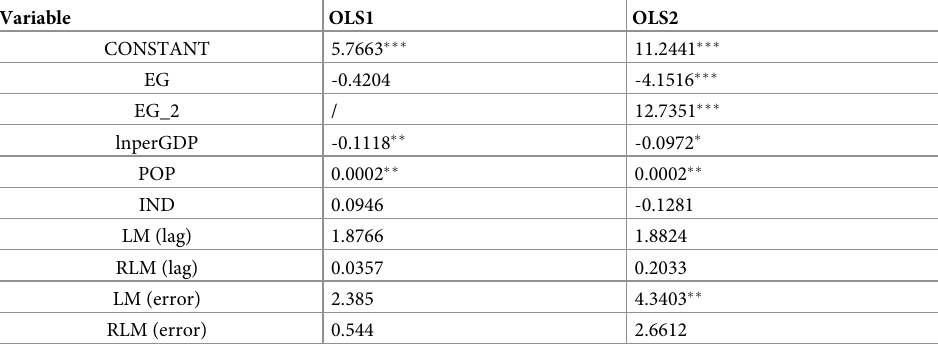
Table 10. Estimation of the impact of enterprise agglomeration on the air pollution of OLS1 and